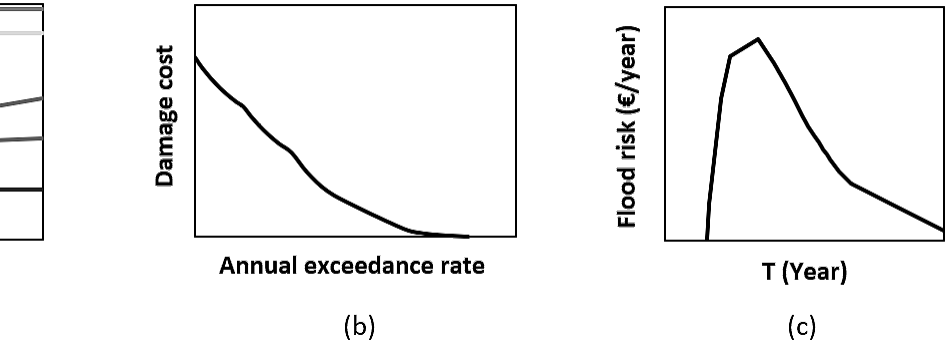
Figure 1. Damage–Depth curve ( a ), Damage—annual exceedance rate curve ( b ) and Flood risk Figure 1. Damage – Depth curve (a), Damage – annual exceedance rate curve (b) and Flood risk den- 129 sity curve (c). density curve ( c